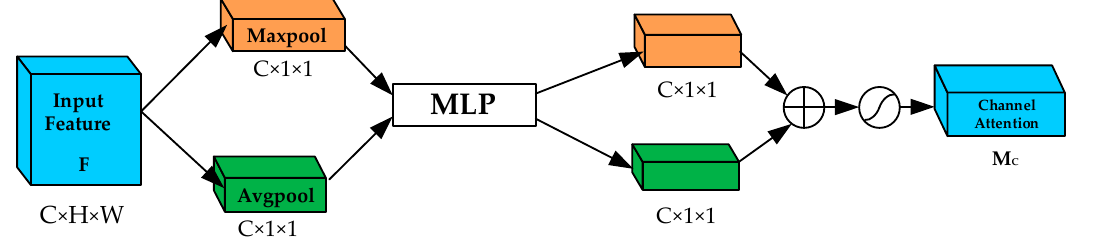
Figure 2. The channel attention mechanism.